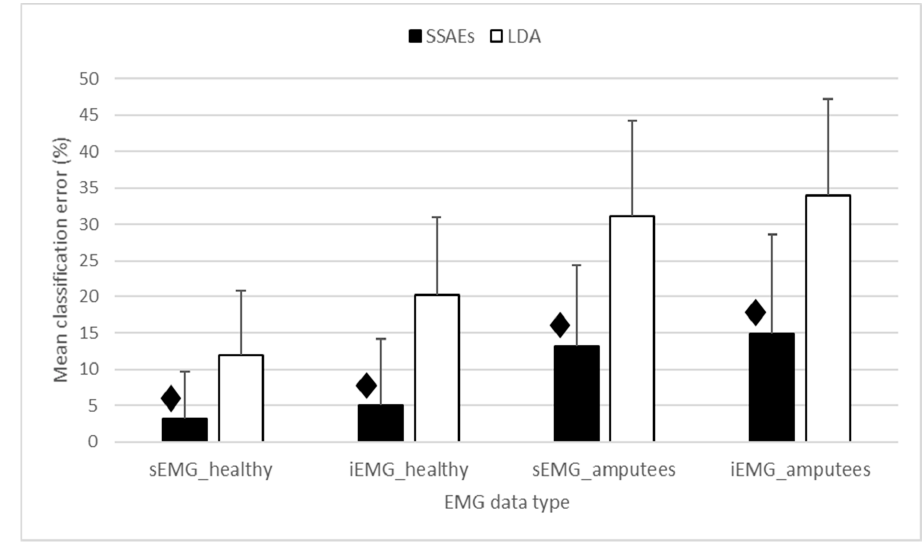
Figure 7. Mean (and SD) classification error obtained with SSAE and LDA for both EMG data types from healthy and amputee subjects. The diamond symbol indicates the best classifier with statistical significance ( p < 0.001) for each EMG data type of both healthy and amputee subjects.